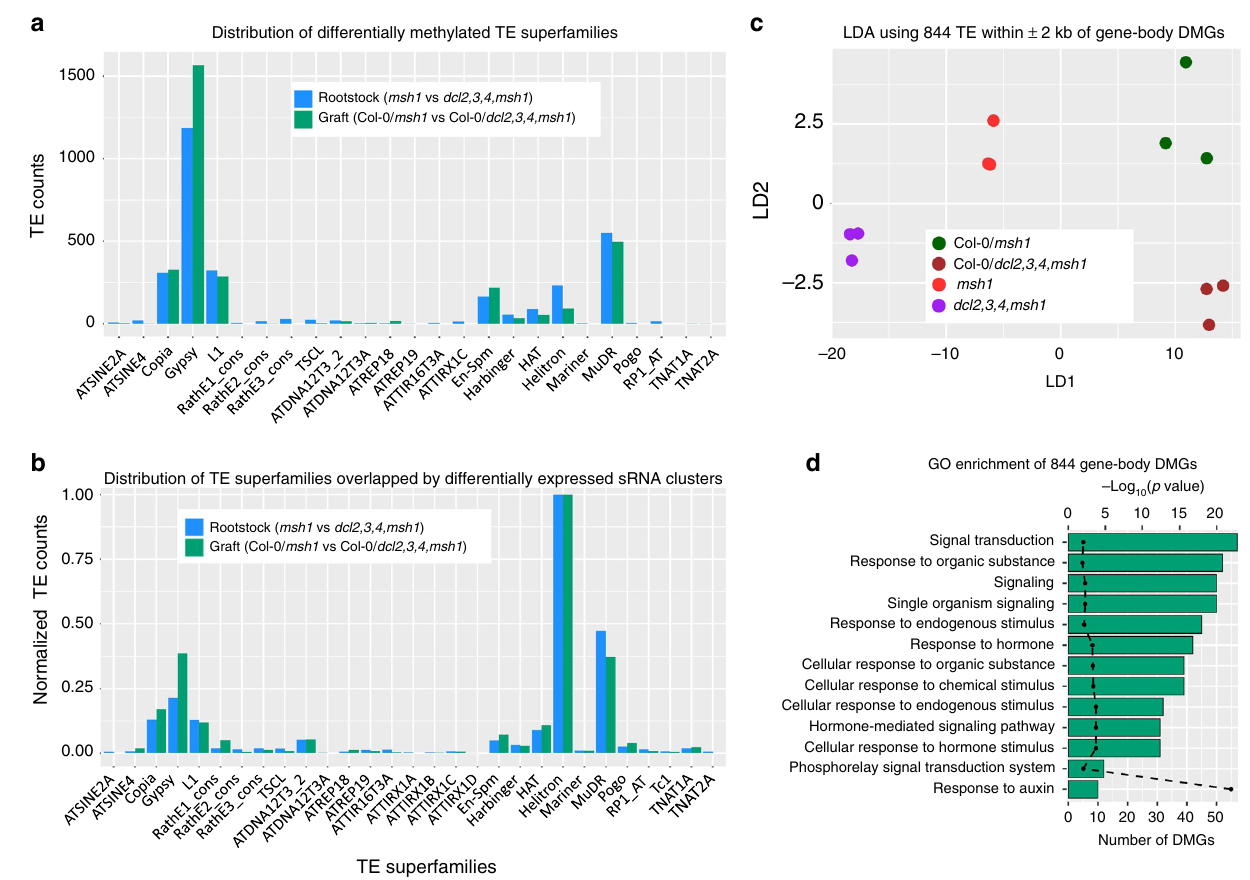
Fig. 5 TE methylation repatterning in the Arabidopsis graft progenies. a Distribution of differentially methylated TE superfamilies in rootstock comparison ( msh1 vs. dcl2,3,4,msh1 ) and graft comparison (Col-0/ msh1 vs. Col-0/ dcl2,3,4,msh1 ). b Distribution of TE superfamilies overlapping with differentially expressed sRNA clusters in rootstock comparison ( msh1 vs. dcl2,3,4,msh1 ) and graft comparison (Col-0/ msh1 vs. Col-0/ dcl2,3,4,msh1 ). c Linear discriminant analysis using absolute methylation level of TEs within ±2 kb of gene-body DMGs. d Network enrichment analysis (NEAT) of TE-associated (±2 kb) gene- body DMGs. p -values were computed using one-sided hypergeometric distribution test as implemented in NEAT (R package version 1.1.3). Source data are provided as a Source Data fi